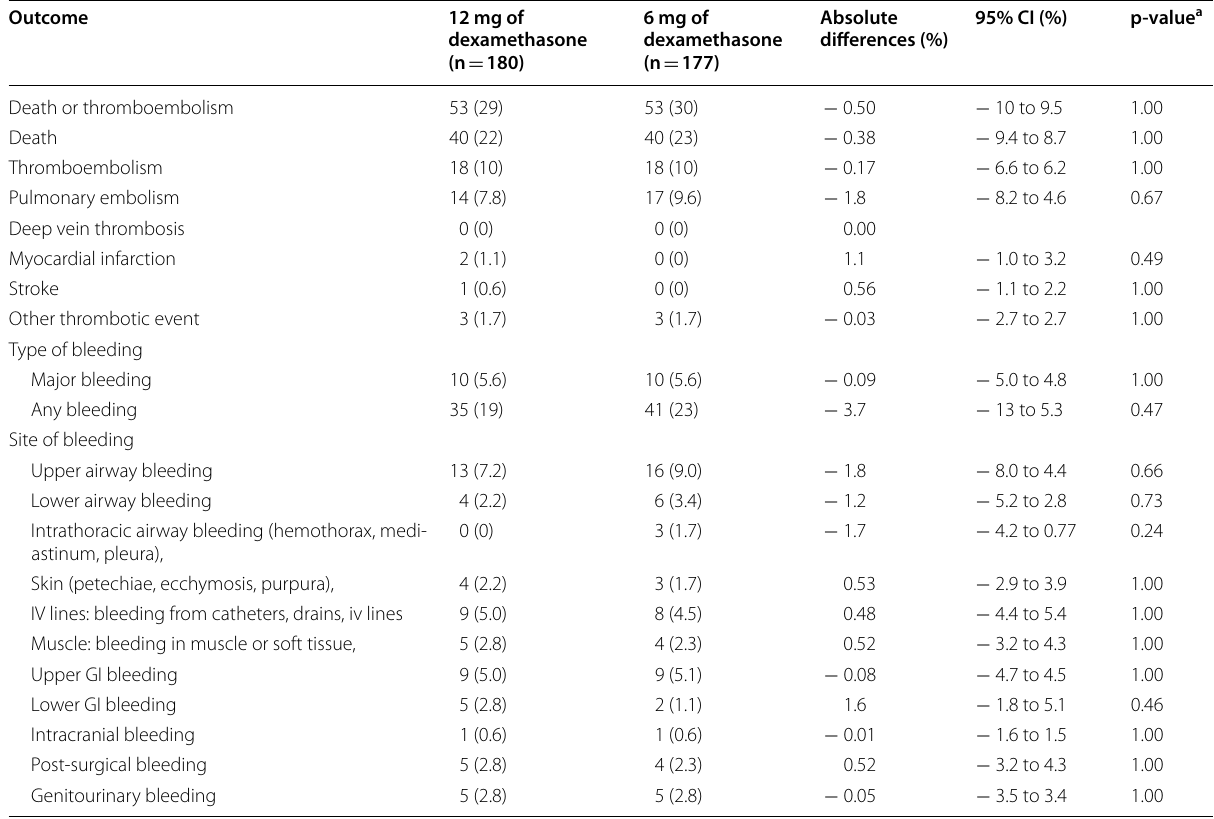
Primary and secondary outcomes during ICU stay among 357 patients with critical COVID-19 by dose of dexamethasone. Values are expressed as no. (%) CI confidence interval, GI gastrointestinal a Two sample test for equality of proportions; 2-sample test for equality of proportions without continuity correction